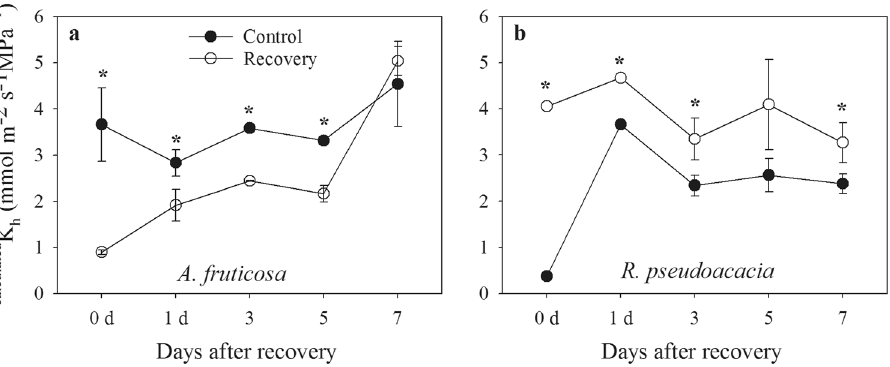
Figure 9. Time-course of whole-plant bulk hydraulic conductance calculated K h , calculated according to Ohm’s analog law, K h = E /( Ψ p − Ψ leaf ), measured after